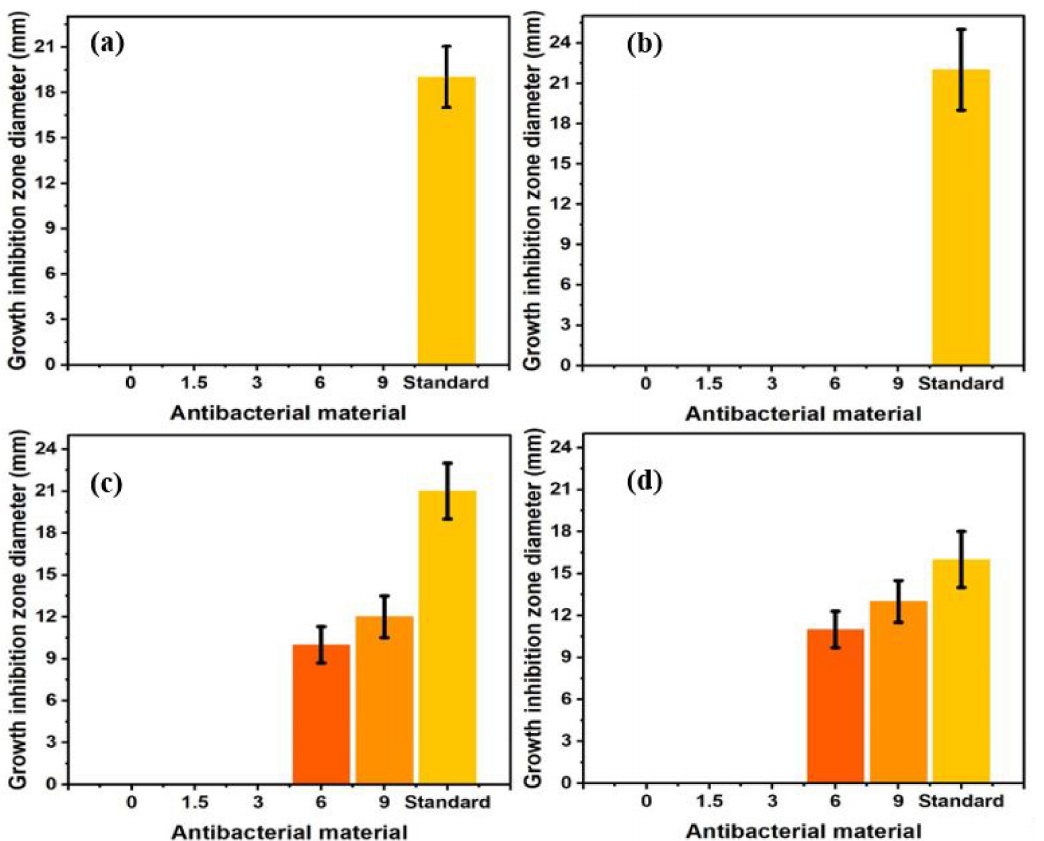
Figure 6. Antibacterial activity of composite scaffolds against ( a ) Escherichia coli , ( b ) Pseudomonas aeru-ginosa , ( c ) Staphylococcus aureus , and ( d ) Methicillin-resistant Staphylococcus aureus ( n = 4). Note: The used standard is cefoxitin